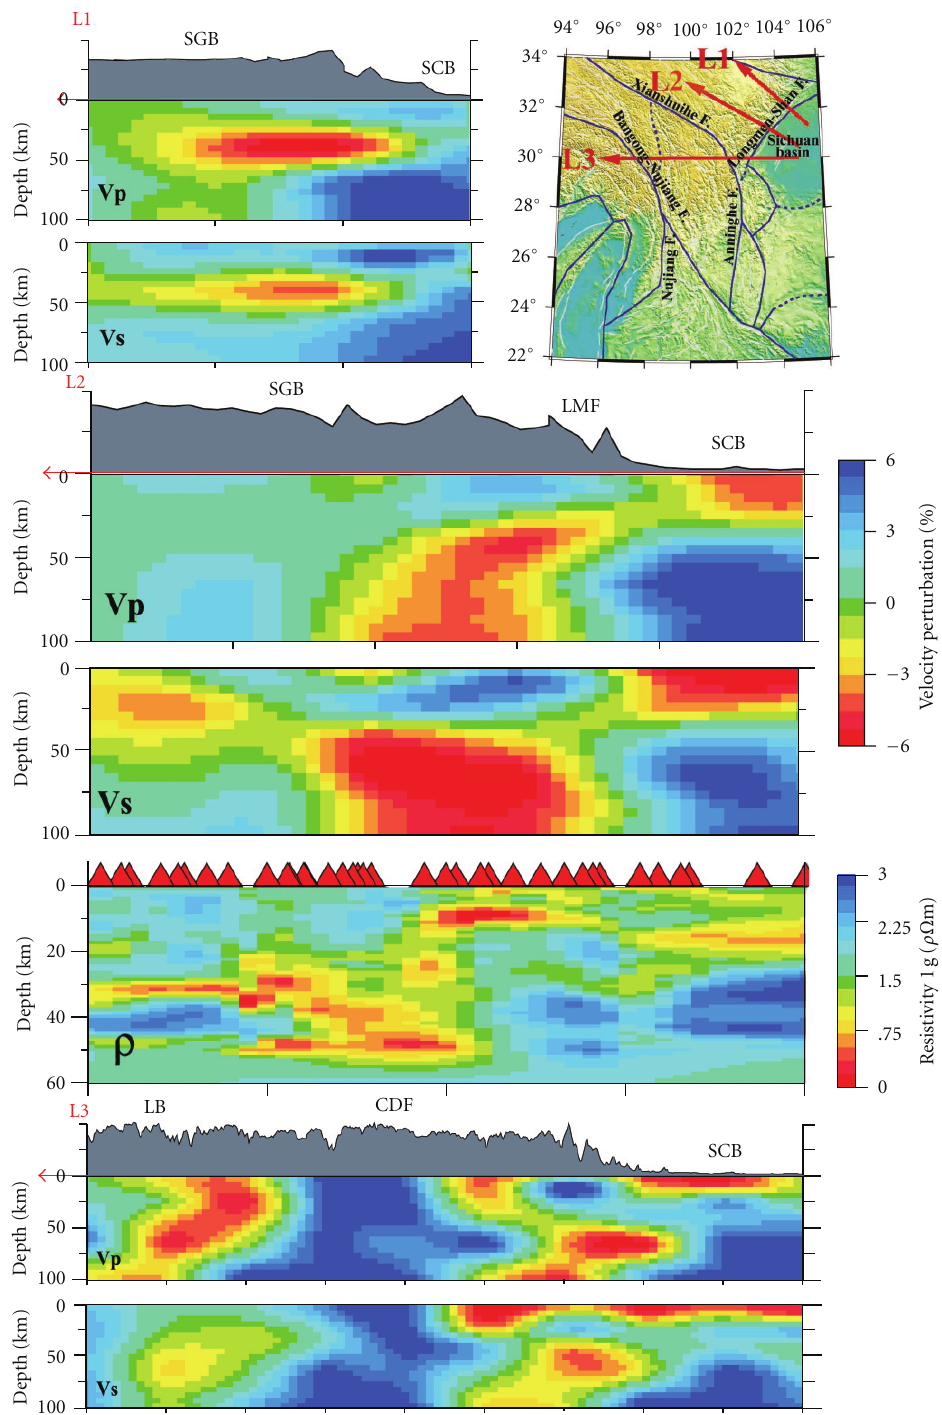
Figure 7: Vertical cross-sections of P- and S-wave velocity images along the lines shown on the upright inset map. Red color indicates low velocity while blue color denotes high velocity. The surface topography is shown on the top of each profile. SGB: Songpan-Ganzi block (fold system). SCB: Sichuan Basin. LMF: Longmen-Shan Fault zone. LB: Lhasa Block. CDF: Chuan-Dian